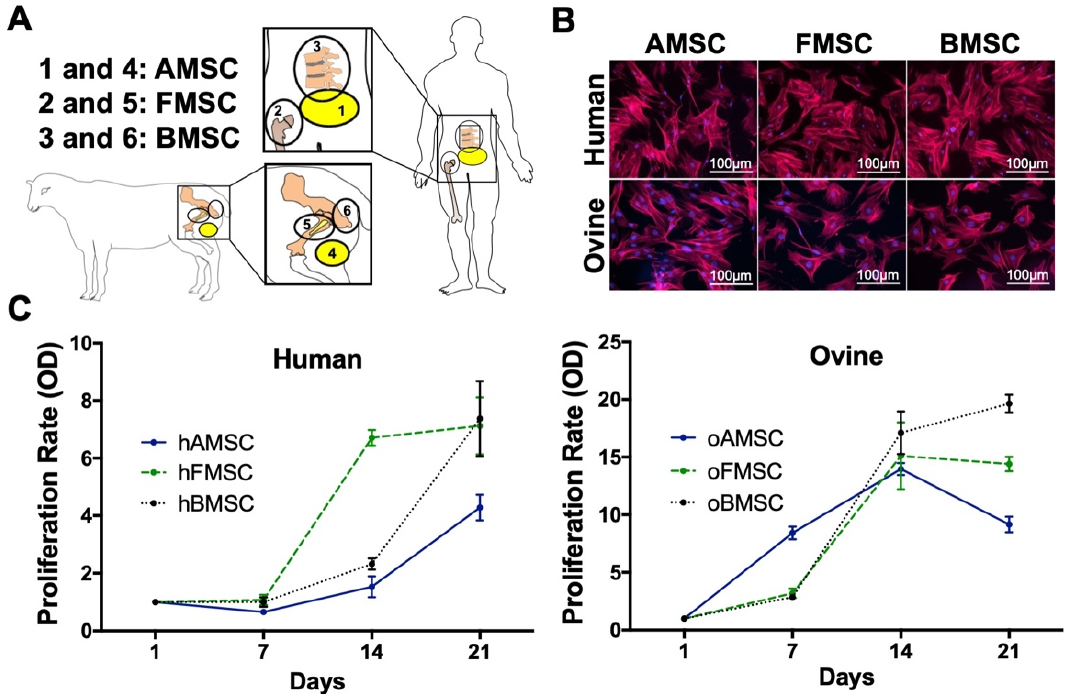
Figure 1. Graphical representation of the different human and ovine mesenchymal stromal cell (MSC) sources as well as their morphology and growth rate of corresponding MSCs. ( A ) MSC isolation from three corresponding human and ovine sources. Human (h)MSCs were harvested from donors undergoing abdomen liposuction cosmetic surgery (1), after hip replacement (2), and during kyphoplasty procedure (3). Ovine (o)MSCs were harvested from thigh adipose tissue (4), femoral marrow fat (5), and the tuber ischiadicum (6). ( B ) MSCs from human and ovine sources showed fibroblast-like morphology. Cytoskeleton-actin (red) and nucleus (blue). Representative pictures are shown. ( C ) MSC growth behavior was defined by measuring the optical density (OD) at the indicated time intervals. MSCs from human sources (left), MSCs from ovine sources (right). Data are expressed as average ± SEM of 3–5 donors per source. AMSC: adipose tissue-derived MSC, FMSC: femoral-derived MSC, BMSC: bone marrow-derived MSC.